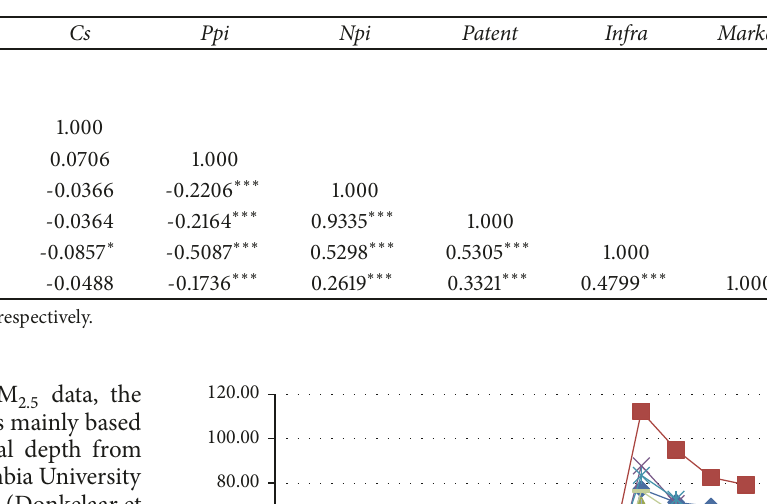
Table 2: Correlations analysis and VIF tests.